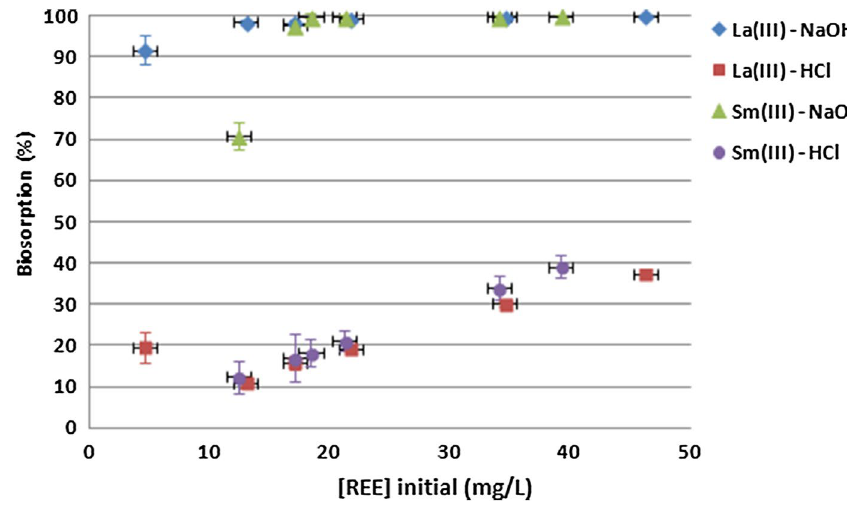
Fig. 2 Effect of initial concen- tration on the biosorption of La 3+ and Sm 3+ by pre-treated Bacillus subtilis cells in binary systems